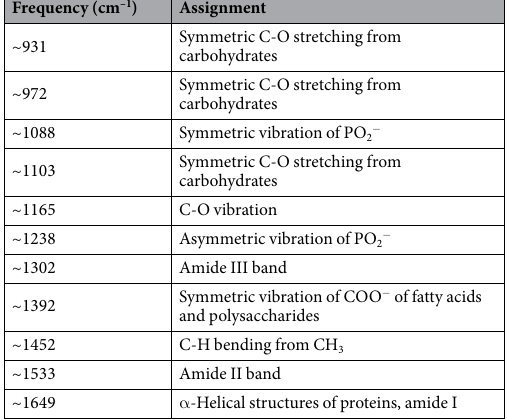
Table 2. ATR FT-IR peak component assignment of